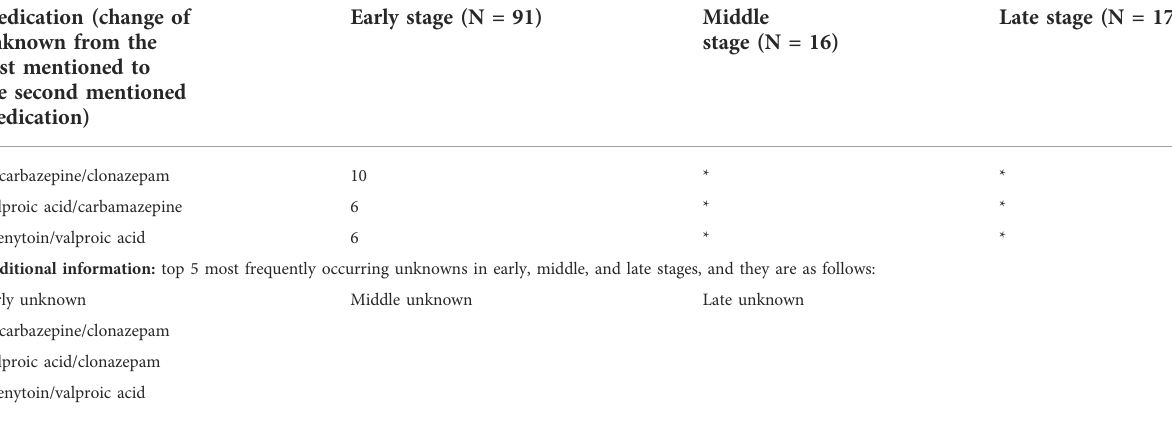
TABLE 4 Manual revision of unknown medication events — phases: early, middle, and